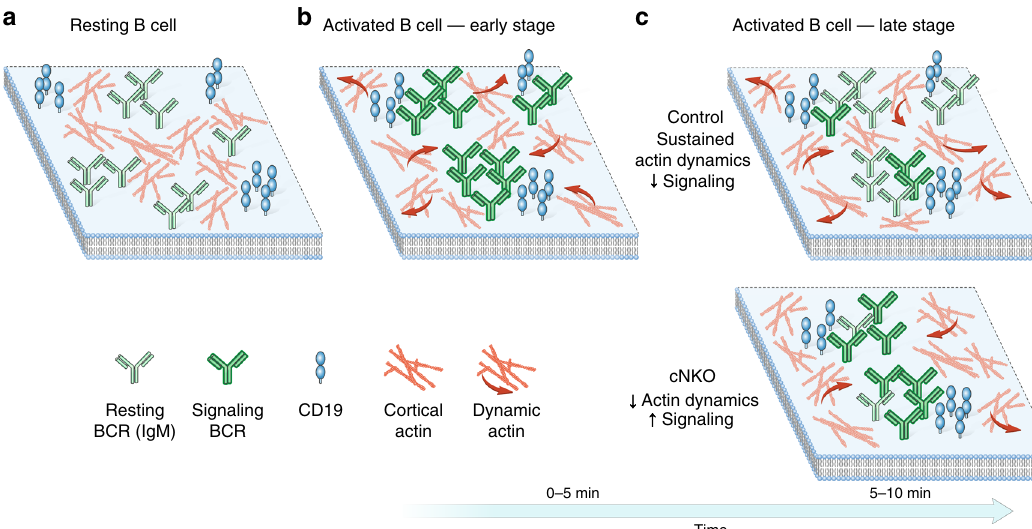
Fig. 8 The actin cytoskeleton regulates B cell receptor mobility and signaling in different stages. Representative cartoon showing receptor distributions on a section of the B cell membrane: a Resting B cell membrane: actin networks restrict receptor lateral movement and interactions. b B cell membrane at the early signaling activation stage. Actin remodeling enhances receptor mobility allowing for interactions between receptors, speci fi cally BCR and CD19, enhancing signaling. Actin fl ows towards the center and edges of the immune synapse in similar proportions. c B cell membrane at later activation stages. Top: actin fl ows stir the cytoplasm at the membrane vicinity, increasing the mixing of receptors in the membrane and thereby allowing signal inhibitory molecules to downregulate BCR signaling. Bottom: N-WASP knockout reduces actin dynamics and changes the balance of actin fl ow directionality at later stages (5 – 10 min) of activation, leading to enhanced